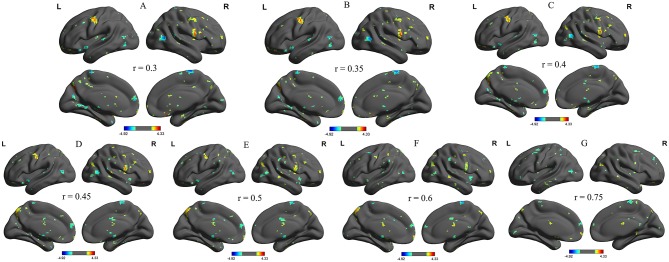
Binarized longFCD maps with several thresholds between alcohol dependent and healthy subjects. We analyzed binarized longFCD differences between alcohol dependent and healthy controls across seven different r-value thresholds (A, r = 0.30; B, 0.35; C, 0.40; D, 0.45; E, 0.50; F, 0.6; G, 0.75). Red color, increased binarized longFCD areas; Blue color, decreased binarized longFCD areas. R, right; L, left; longFCD, Long-range FCD.